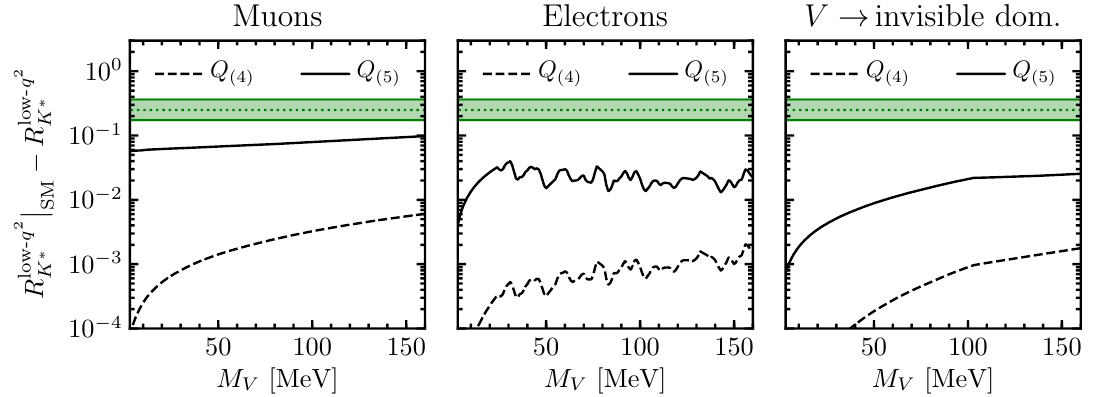
Figure 8 . Maximal e(cid:11)ects from Q and Q in the low- q 2 bin of R K (cid:3) from the o(cid:11)-shell exchange (4) (5) of a light vector, V , as function of the vector mass. In the left panel, V decays solely to muons with a coupling that saturates the (cid:23) -trident bound from the left panel of (cid:12)gure 7. In the central panel, V decays solely to electrons with a coupling saturating the bounds in the central panel of (cid:12)gure 7. In the right panel, V couples to electrons but primarily decays invisibly, the maximally allowed coupling to electrons is plotted in the right panel of (cid:12)gure 7. For each case, we show the maximal (cid:12) (cid:12) value of R [0 : 045 ; 1 : 1] (cid:0) R [0 : 045 ; 1 : 1] as a function of the V mass. We see that the e(cid:11)ects are (cid:12) (cid:12) K (cid:3) K (cid:3) SM Q ( d ) much smaller than the current discrepancy (horizontal green band).